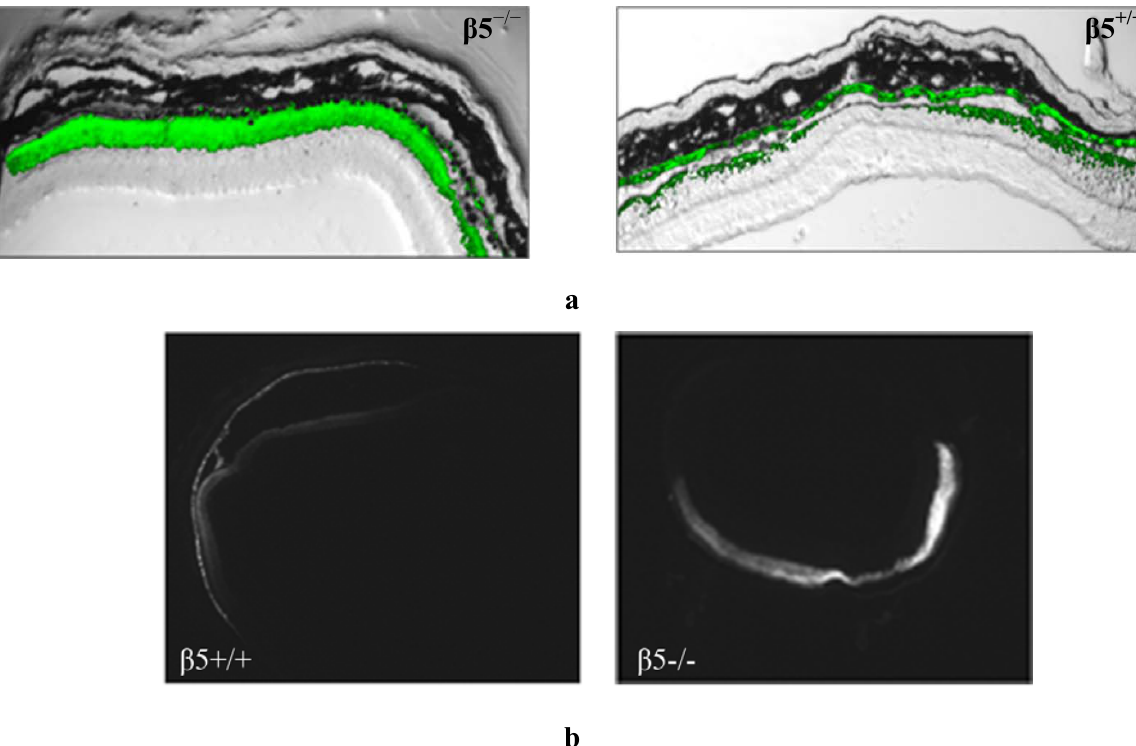
Figure 2. Frozen retinal sections taken from mice (n = 10), 5 weeks after sub-retinal injection with AAV2/5(CMV-eGFP). ( a ) The representative level of fluorescence in a mouse that has no functional expression of the β 5 integrin receptors ( β 5 − / − ) compared to WT ( β 5 +/+ ) are shown at 20X magnification; ( b ) Comparable nomarski full-field images are shown in 4×